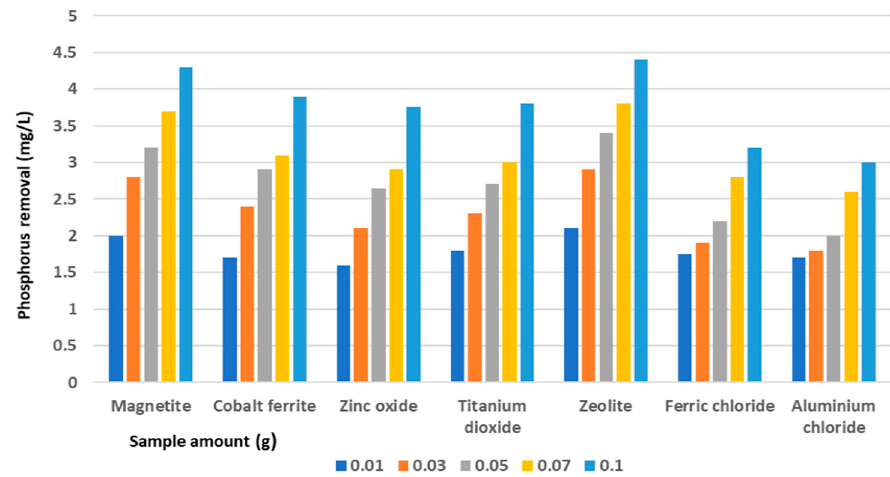
Figure 10. The effect of adsorbent dosage on phosphorus removal.